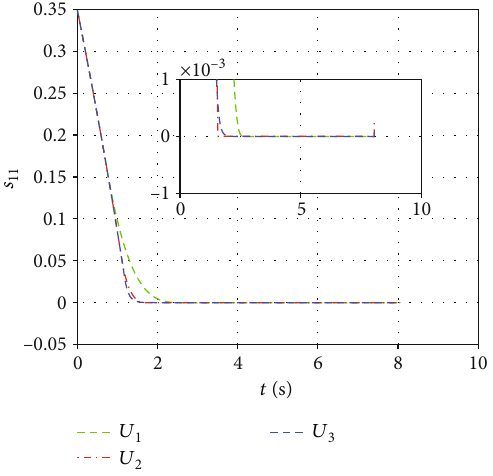
Figure 5: Dynamic error surfaces s